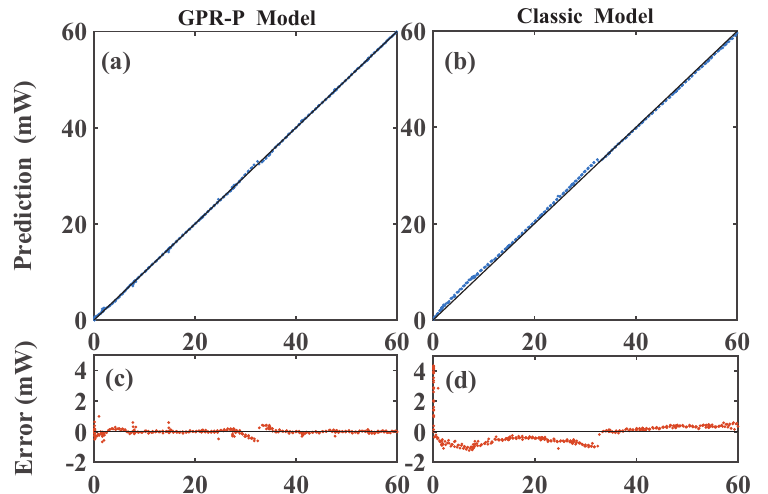
Figure 3. Predictions and errors for each point by the GPR − P model and classic model. ( a ) Predictions of the GPR − P model. ( b ) Errors of the GPR − P model. ( c ) Predictions of classic model. ( d ) Errors of the classic model.